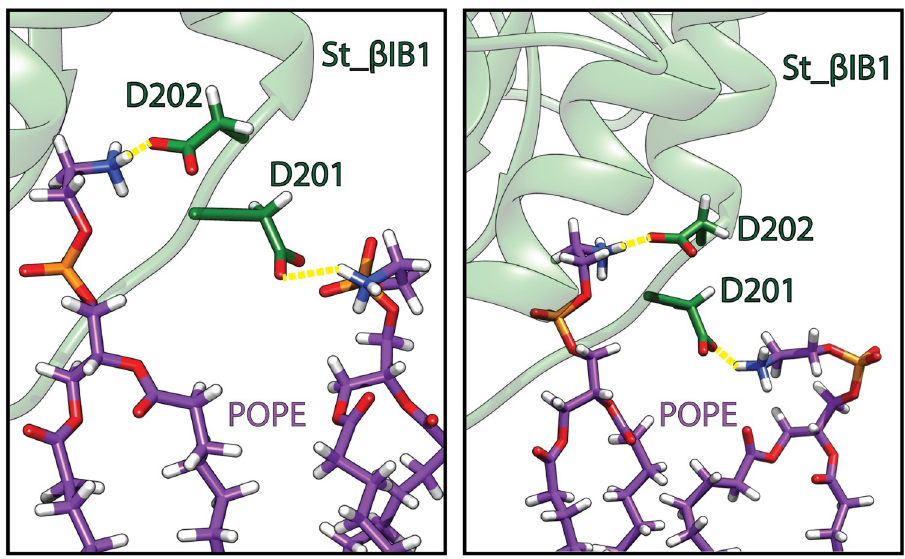
Fig 6. Hydrogen bonds (yellow) between residues D201 and D202 of St_ β ID1 and phosphatidylethanolamine headgroups: POPE lipid (carbon atoms in purple), protein (green). The two snapshots are taken during the last 50 ns of